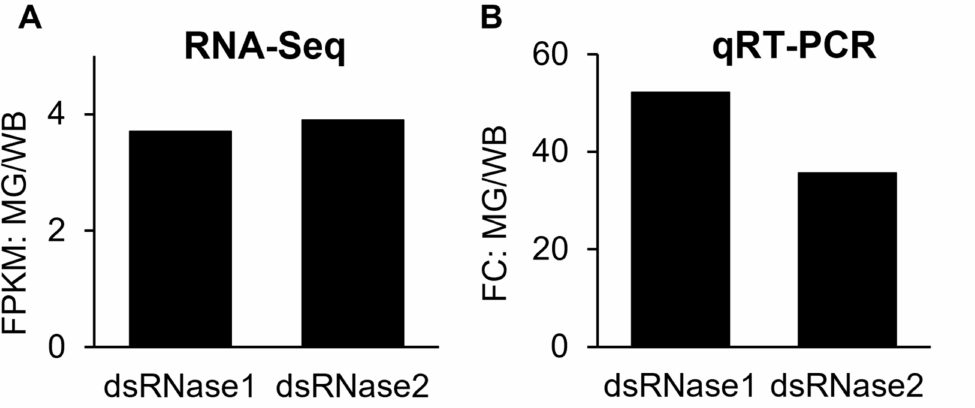
Figure 3. Expression of dsRNase genes in the midgut of Drosophila suzukii as measured by RNA-Seq ( A ) and qRT-PCR ( B ). Ratios of FPKM (fragment per kilobase of transcript per million mapped reads) and FC (fold change) of the midgut (MG)/whole-body